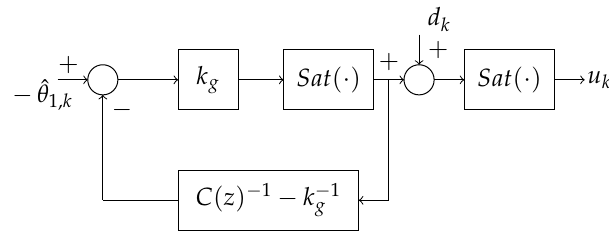
Figure 1. Anti-windup proportional-integral